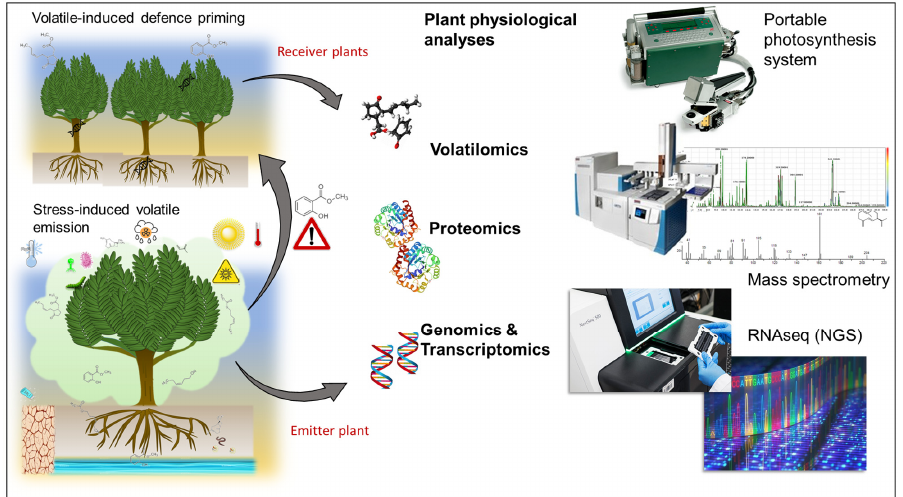
Figure 5. Integrating physiological, metabolome, proteome, and transcriptome analyses in under- standing plant volatile signalling.